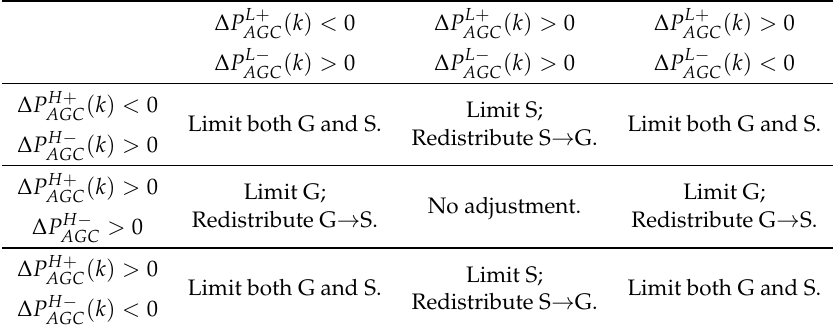
Table 1. The operation guidance for the amplitude limiting and redistribution.